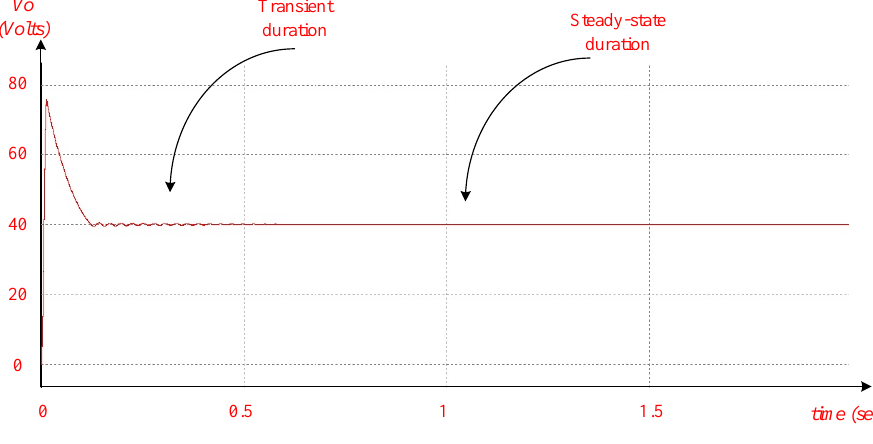
Figure 6. Output voltage simulation waveform for D = 0.75.